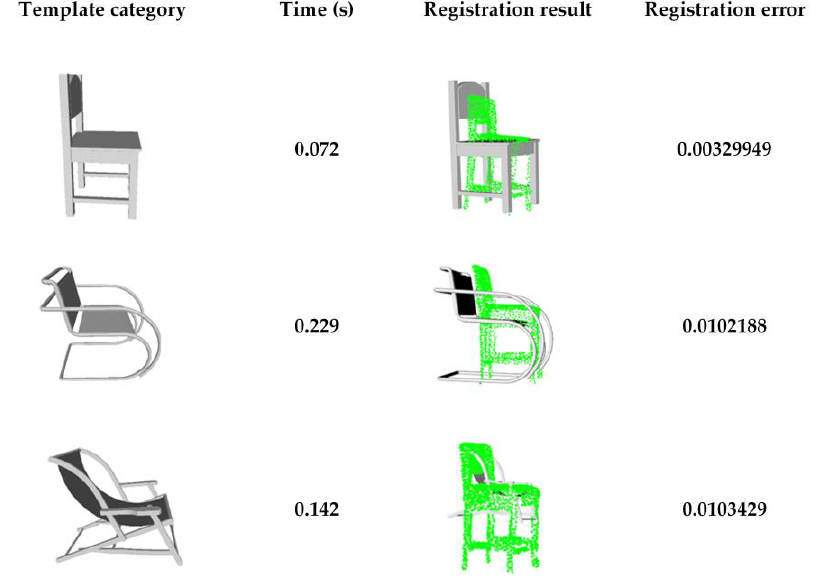
Figure 13. The following coarse registration experiment.